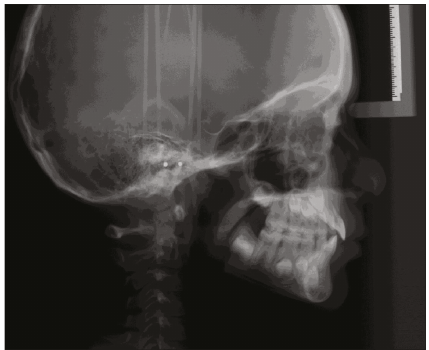
Figure 8: Posttreatment cephalograph.